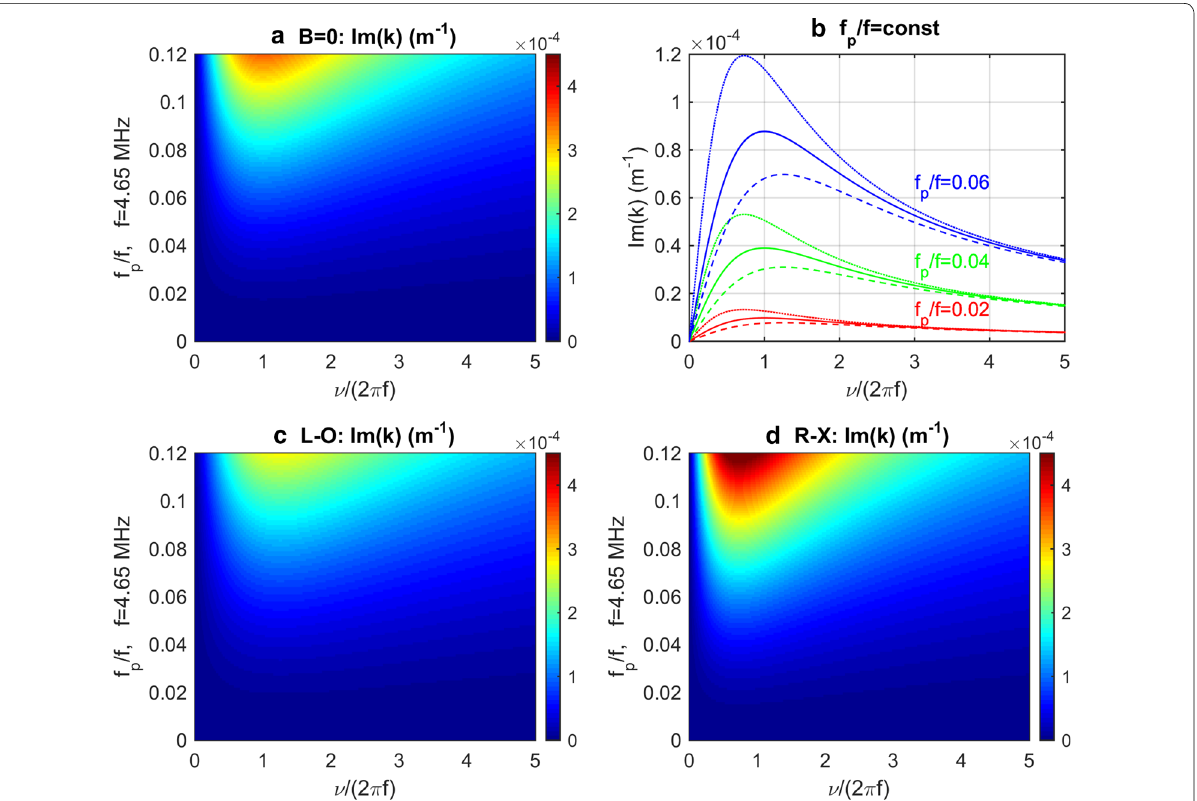
Fig. 2 Imaginary part of wave vector Im(k) for frequency f unmagnetized plasma. b Im(k) as a function of ν/(2πf) for f p /f plasma by solid, L‑O mode by dash, R‑X mode by dot‑dash. c Color‑coded values of Im(k) as a function of f p /f and ν/(2πf) for L‑O mode. d Color‑coded values of Im(k) as a function of f p /f and ν/(2πf) for R‑X